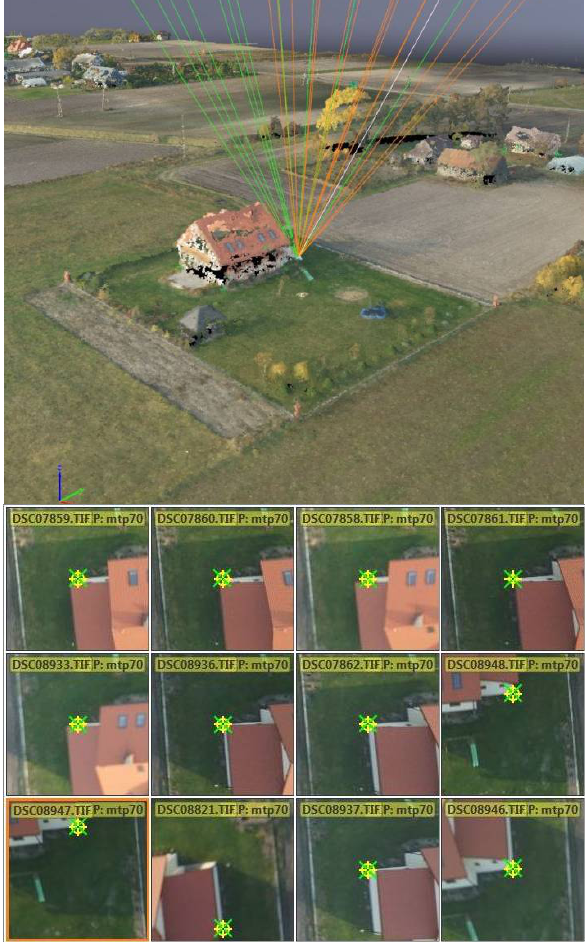
Figure 6. An example of an intersection with the use of the multi-photo measurement